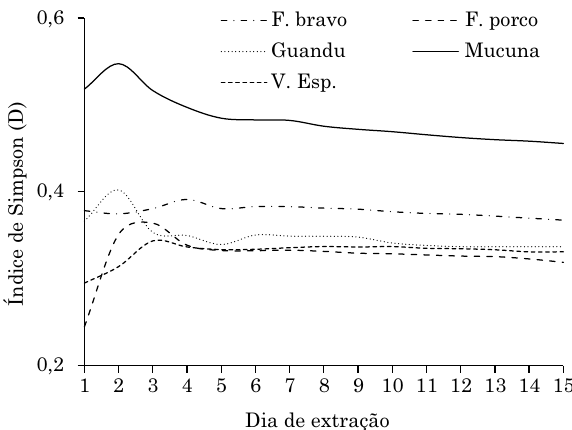
Figura 5. Variação diária do índice de Simpson (D), em razão da quantidade de organismos capturados, discriminada por tratamentos [feijão-de-porco ( Canavalia ensiformis ), mucuna-preta ( Mucuna aterrima ), feijão-bravo-do-Ceará ( Canavalia brasiliensis ), guandu ( Cajanus cajan ) e vegetação espontânea], referente à segunda coleta.